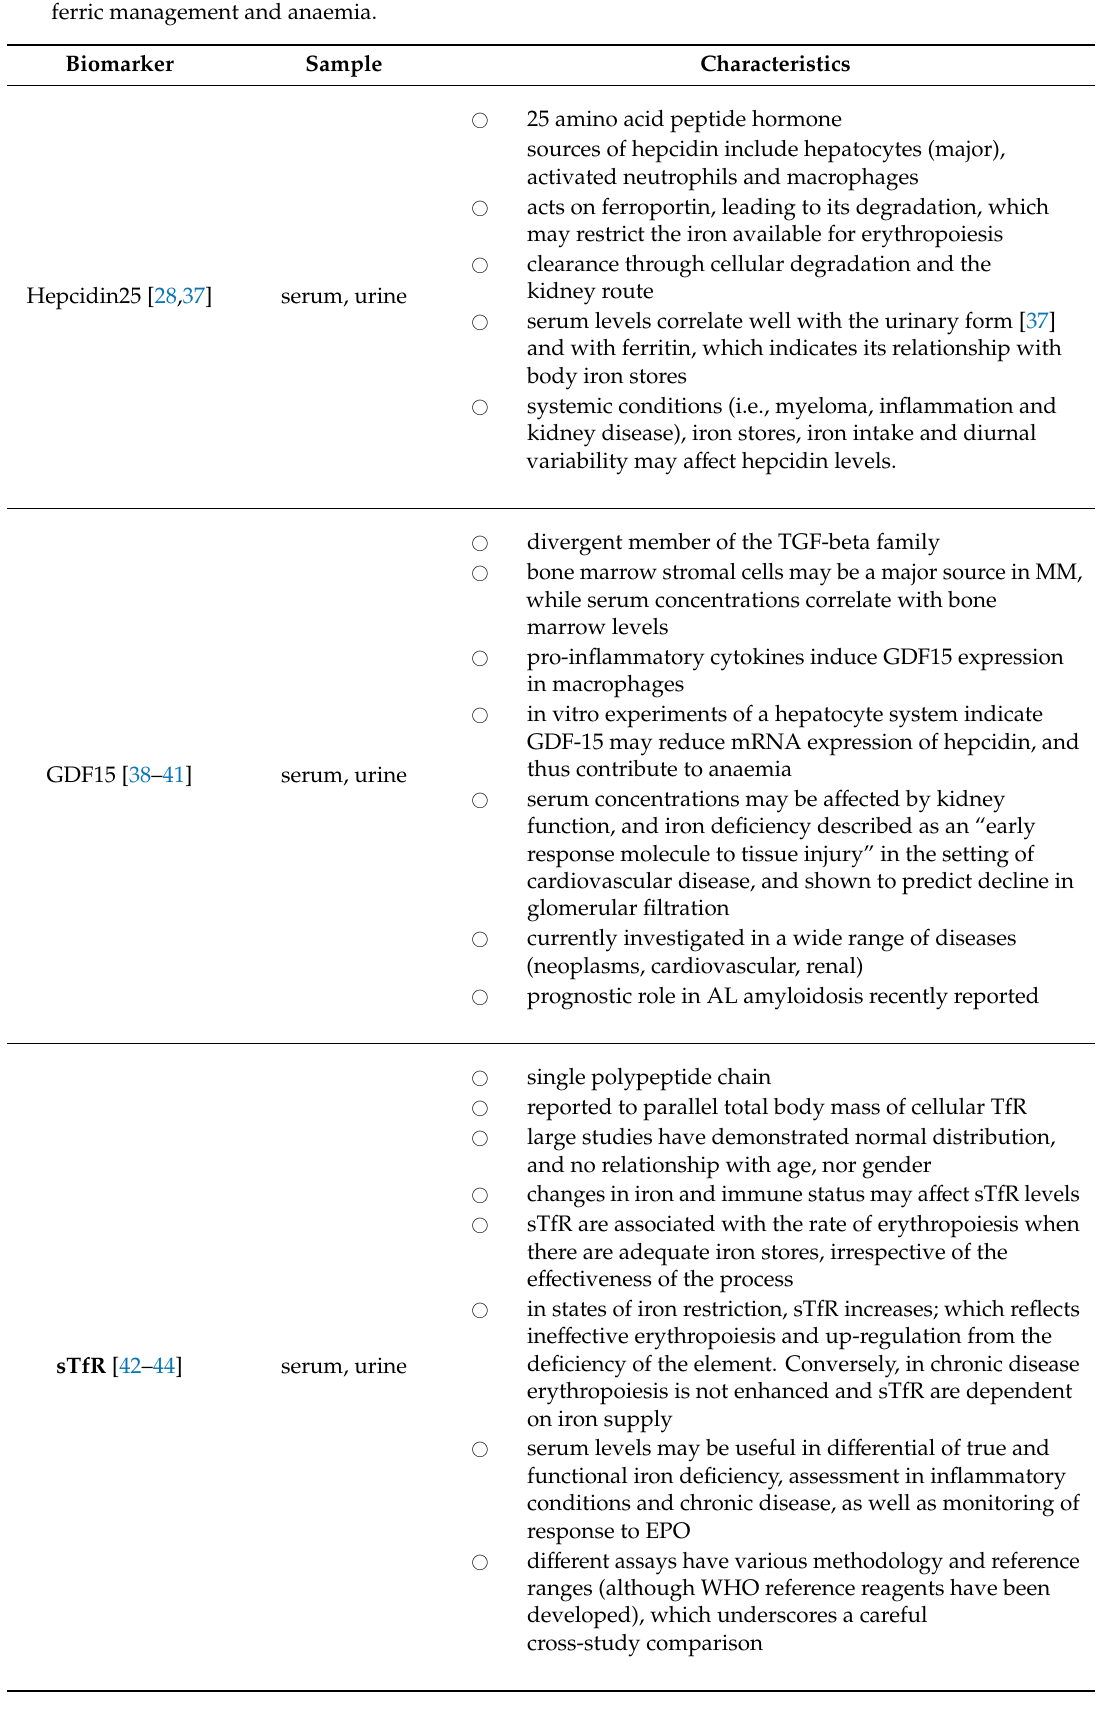
Table 2. New biomarkers of processes involved in myeloma-associated complications with a focus on ferric management and